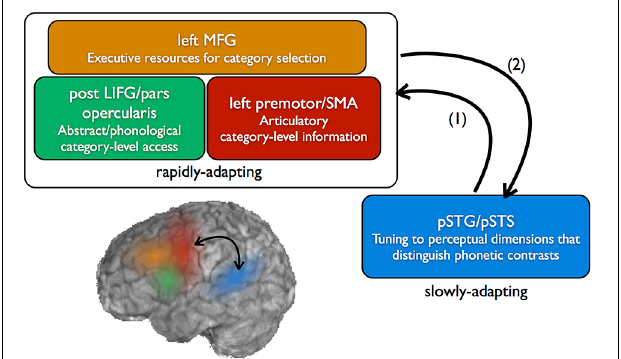
FIGURE 2 | Neural systems for the perception and learning of speech sound categories. Fine-grained sensitivity to acoustic dimensions that distinguish native speech sounds (e.g., VOT) is found in the posterior superior temporal gyrus (pSTG) and superior temporal sulcus (STS), which includes preferential sensitivity to speech categories, but, to a lesser degree, also sensitivity to within-category variation. In perception, sounds which are not well-categorized by this tuning (e.g., ambiguous sounds) feed forward to categorical-level coding in the frontal lobe (1). For non-native category learning which relies on top-down feedback, category sensitivities may emerge first in the frontal lobe, then feed back to posterior temporal areas to guide long-term changes in perceptual sensitivity (2). This frontal-to-temporal feedback corresponds to the top-down learning route shown in the bottom left portion of Figure 1